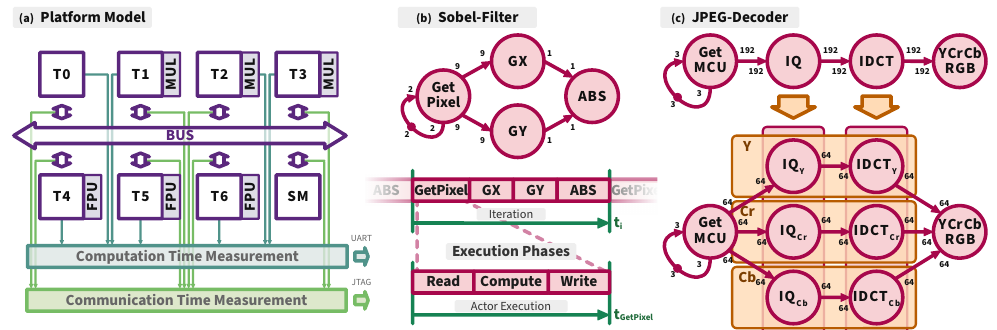
Figure 2. ( a ) Shows the architecture model of our evaluation platform (purple) and the measurement infrastructure (green) for characterization. ( b ) Shows details of the computation model on our Sobel- Filter Use-Case. ( c ) Shows our JPEG decoder Use-Case with and without considering data dependent